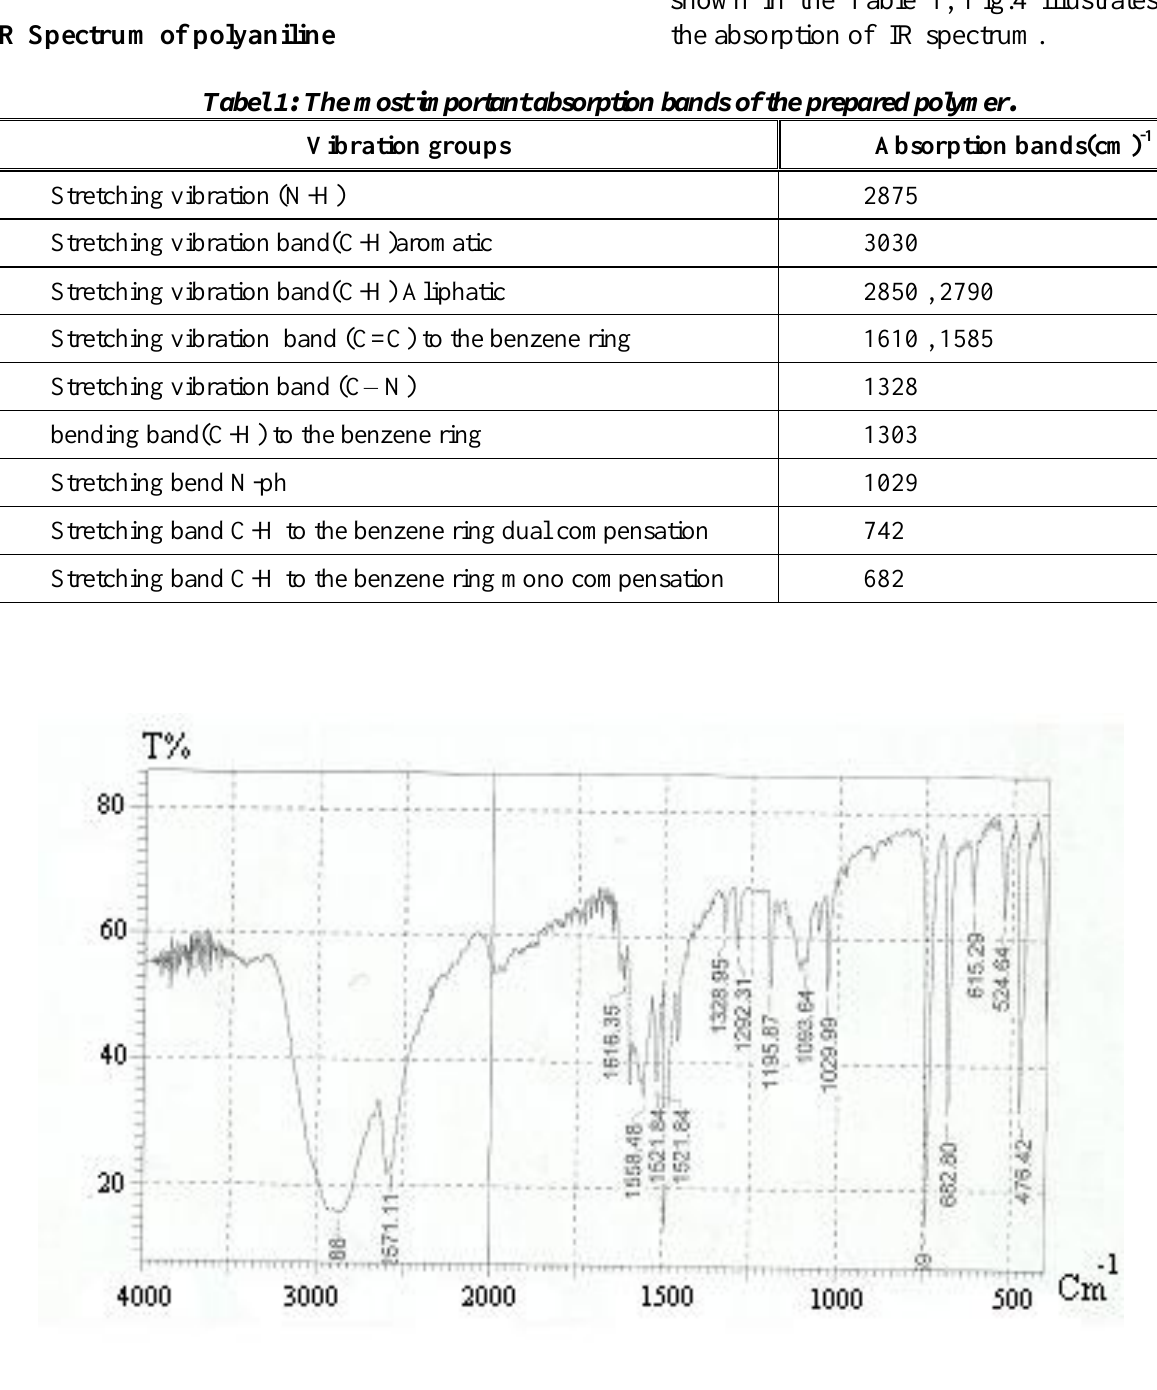
Fig.4: IR spectrum for polyaniline thin